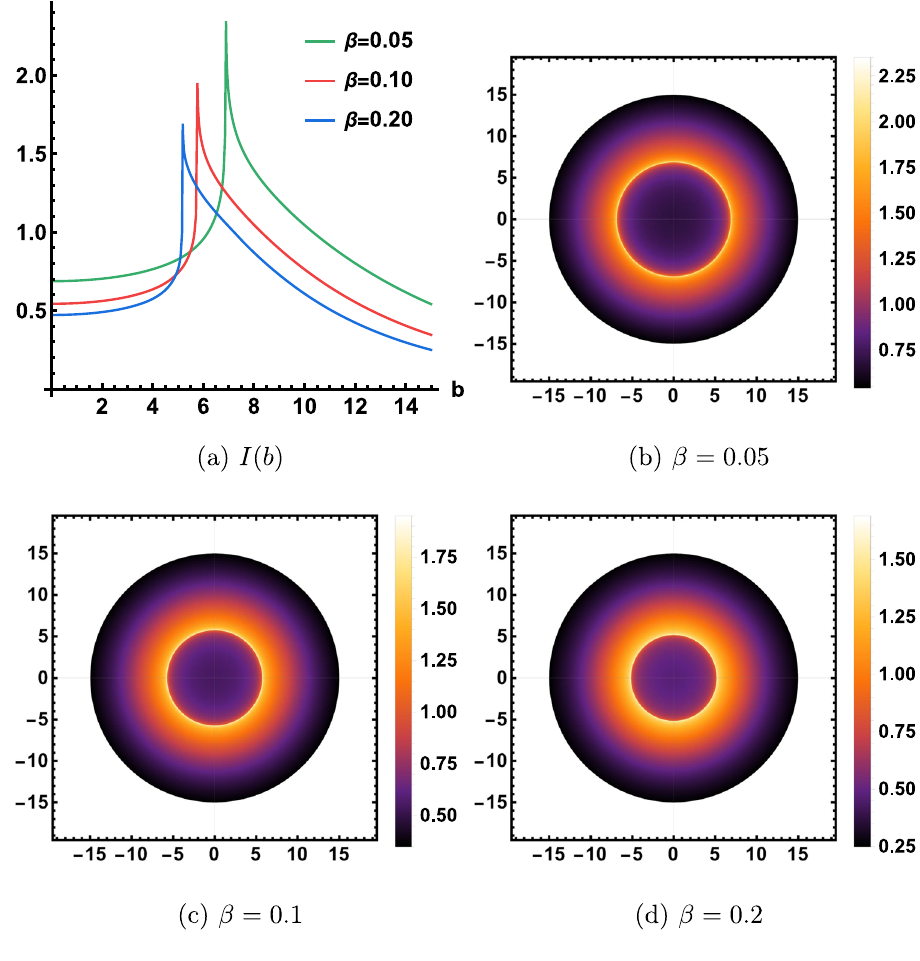
Fig. 6 The specific intensity I with respect to different impact parameters b in the top-left panel. And the other figures are the BH shadows with static accretions for different BI parameters β with P = 0 . 6 and M =